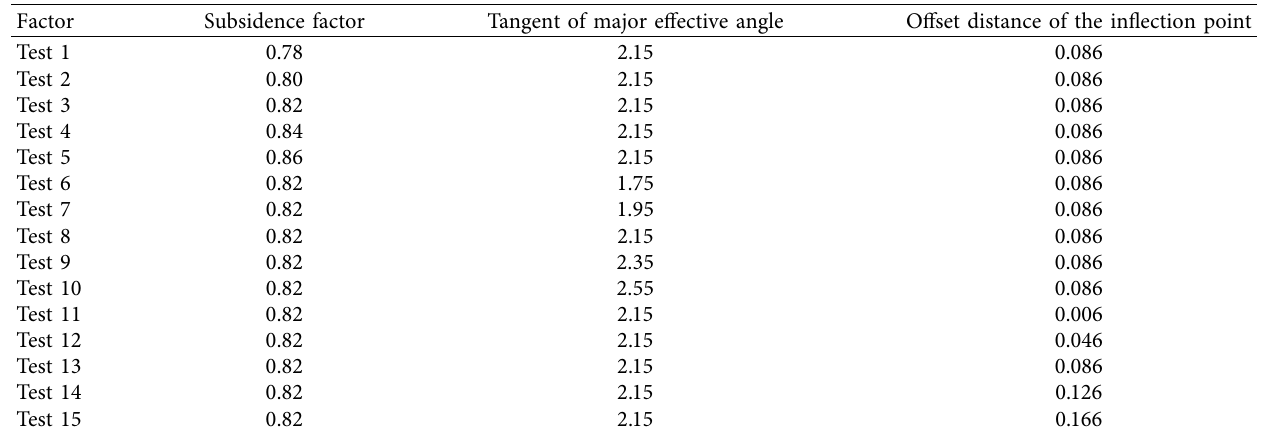
Table 2: Description of test